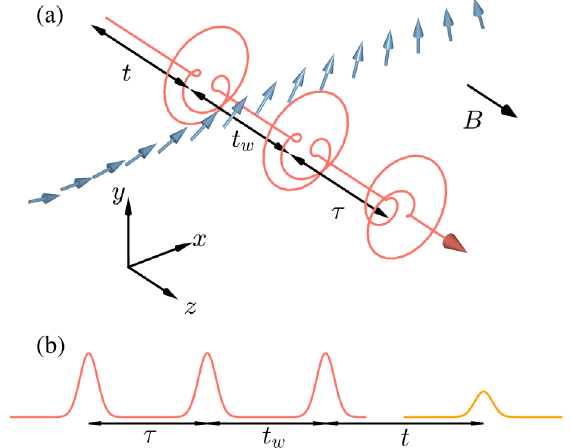
FIG. 1. (a) The Faraday configuration considered in this work. A magnetic field B is applied in the z axis. Three short electromagnetic pulses with circular polarizations pass through the S ¼ 1 = 2 spin chain. The propagation direction is parallel with the spin z axis. The first pulse is right-handed, whereas the second and the third are left-handed. We denote the time delay between the first and the second pulse by τ , the second and the third by t w , and the third pulse and the time of detection by t . (b) The photon echo appears as the surge of nonlinear optical response at the time t ≈ τ